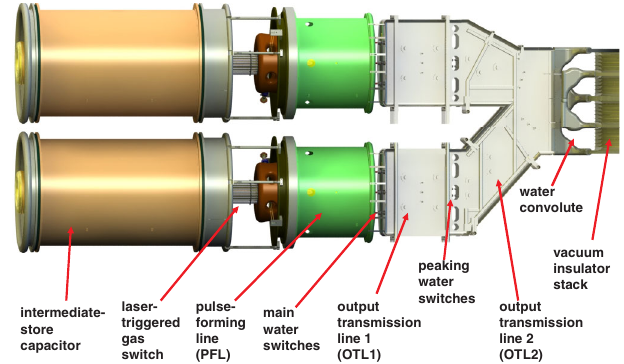
FIG. 2. (Color) Schematic of two pulse-forming sections of ZR with principal components labeled (dimensions in centimeters). Not shown here are the vacuum MITLs and load